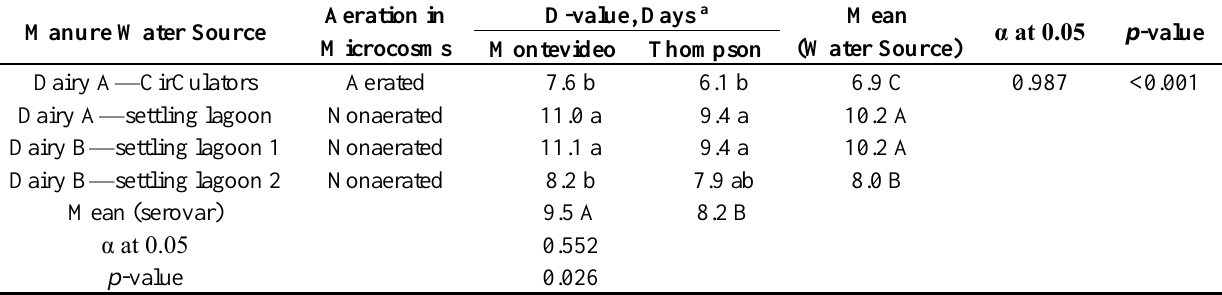
Table 5. Effect of aeration in microcosms prepared from wastewater from two dairies with different manure management practices on survival of Salmonella enterica serovars.